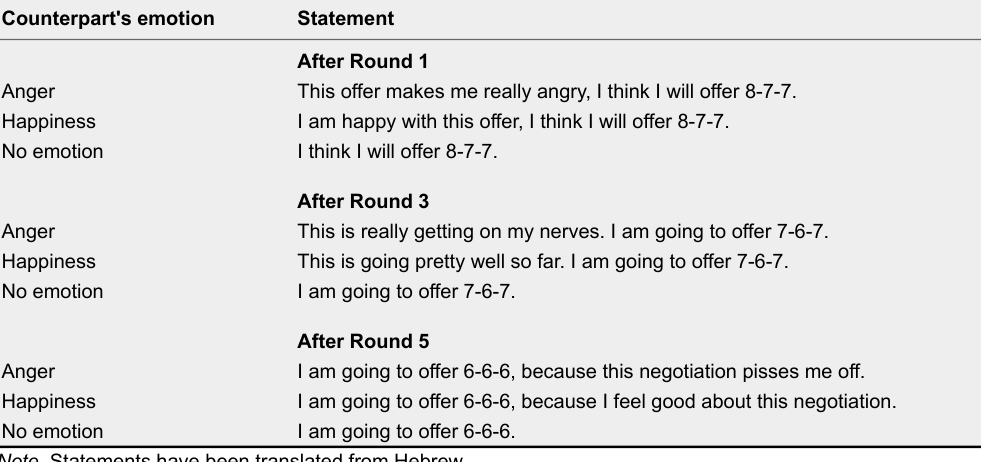
Statements Used for the Manipulation of the Counterpart's Experienced Emotion StatementCounterpart's